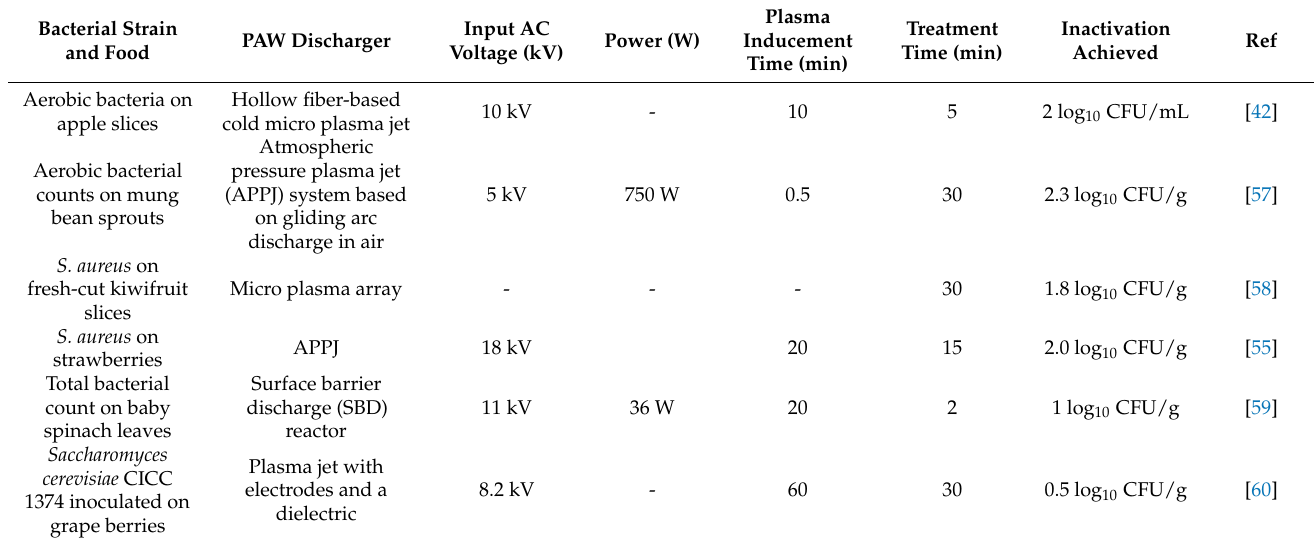
Table 2. The effect of PAW on microbial inactivation on fruit and